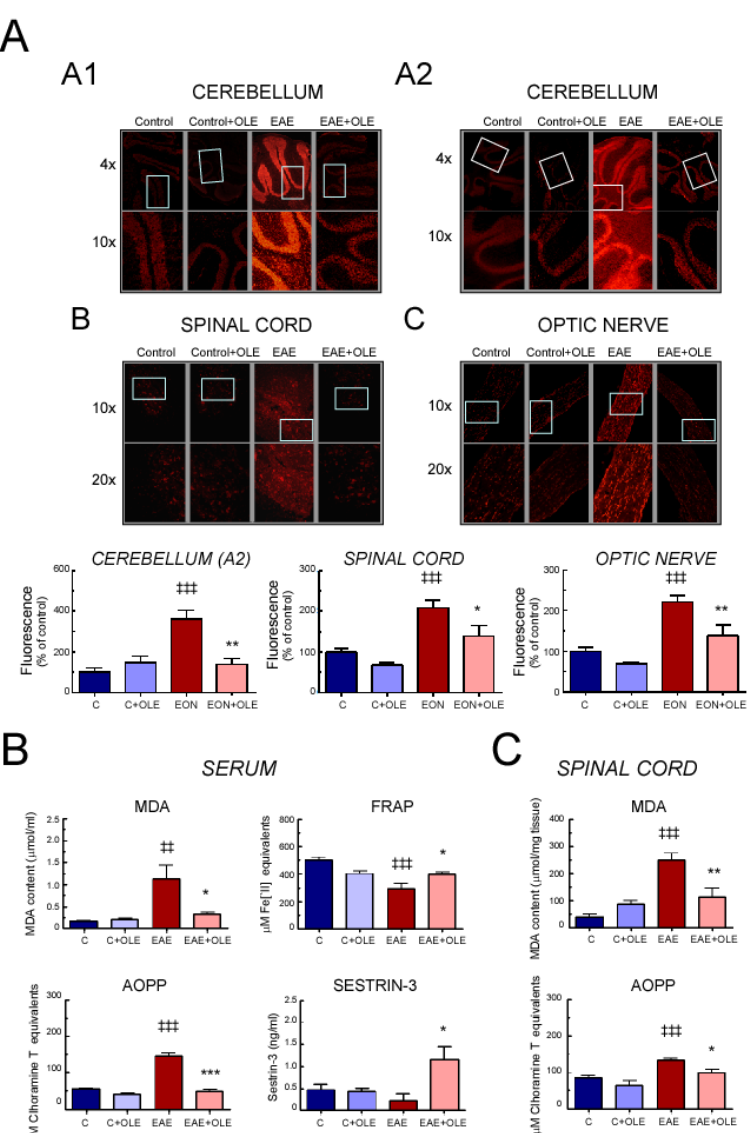
Figure 5. Oleacein treatment protects EAE mice from oxidative stress. Cerebellum, spinal cord and optic nerve from control and EAE mice treated with vehicle or OLE were analyzed at day 23 post-immunization. ( A ) Representative microphotographs of CNS tissues sections labeled with DHE, analyzed by fluorescence microscopy. Cerebellum: AA1 and AA2 panels represent the same sections visualized at different settings. Cerebellum: upper and lower panels represent a same section visualized with different magnification: 4× and 10× lens, respectively. Spinal cord ( AB ) and optic nerve ( AC ): upper and lower panels represent a same section visualized using a 10× or a 20× lens, respectively. Quantification graphs can be seen underneath the images. Levels of malondialdehyde (MDA), advanced oxidation protein products (AOPP) and ferric-reducing antioxidant power (FRAP) and sestrin-3 in serum ( B ), and MDA and AOPP levels in spinal cord ( C ) of the same animals. Bar graphs represent the mean ± SEM of 5–8 animals, from two independent experiments. ‡‡‡ p < 0.001 and ‡‡ p < 0.01 vs. control; and *** p < 0.001, ** p < 0.01 and * p < 0.05 vs.